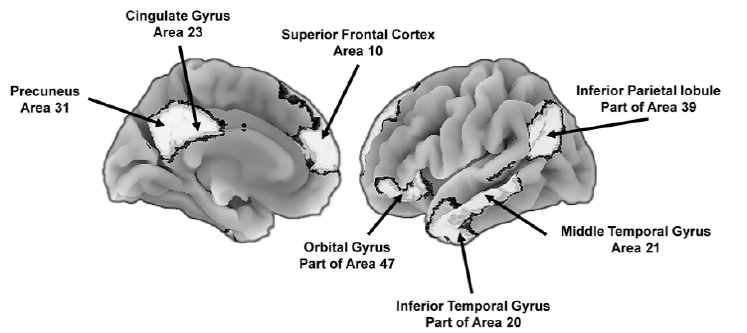
Figure 4. Key brain areas of the default mode network that support the construction of self-centered mental representations of the world, including potential future states. To the left is the medial (center) view of the brain and to the right is the lateral (outer side surface) view. The numbers next to the labels are Brodmann [51] map coordinates.